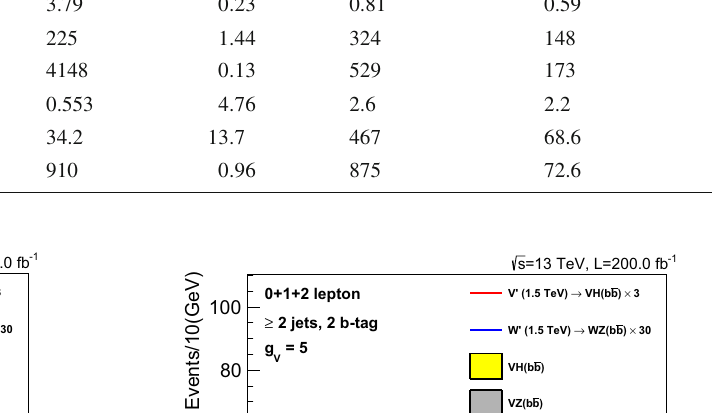
Table 1 Signal yield and resonant SM background yields for a 1.5 TeV resonance, g V = 5 and an integrated luminosity of 100 fb − 1 , after baseline selection, and after an additional p ⊥ > 200 GeV cut (last column). The resonance width over its mass is Γ/ m (cid:6) 10%